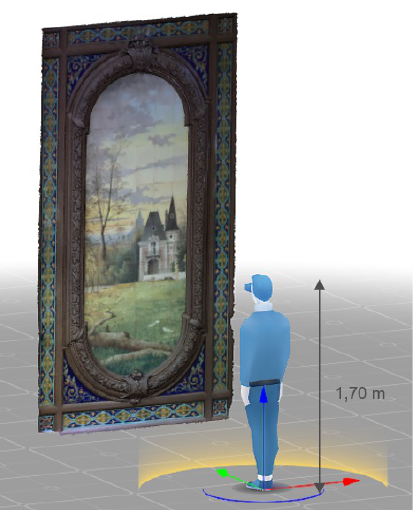
Figure 7. Setup of the Virtual Reality Tool for the “Pavillon Figure 6. Fountain without (left) and with (right) histogram equalization